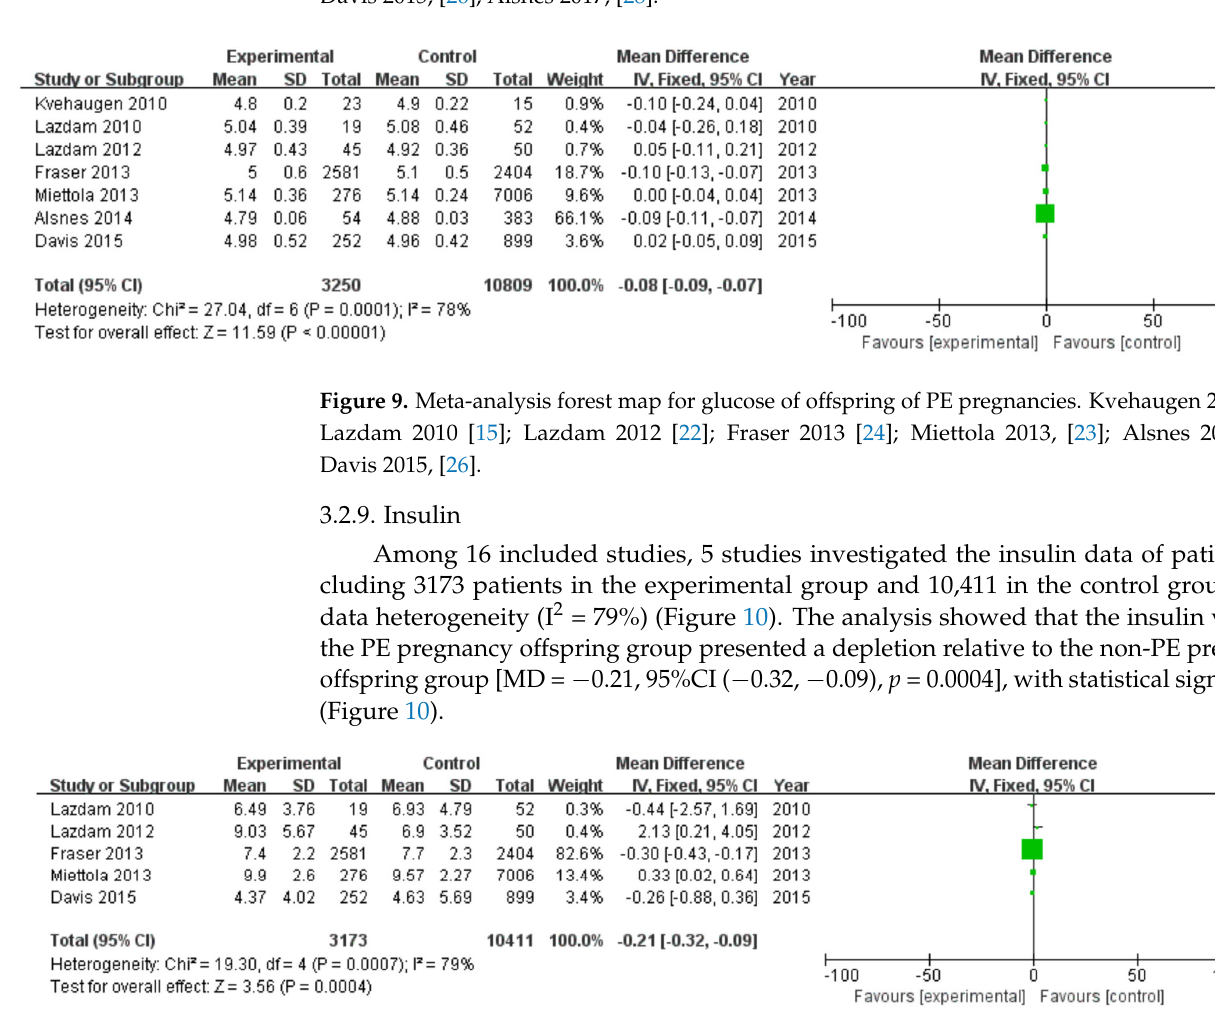
Figure 10. Meta ‐ analysis forest map for insulin of offspring of PE pregnancies. Lazdam 2010 [15];